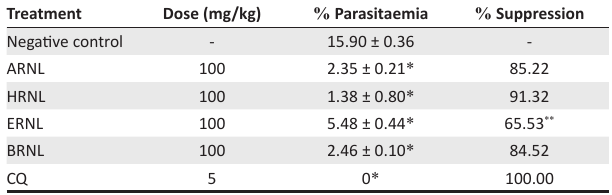
TABLE 1: Suppressive activity of Nauclea latifolia roots extract and fractions against Plasmodium berghei -infected mice (4-day test).